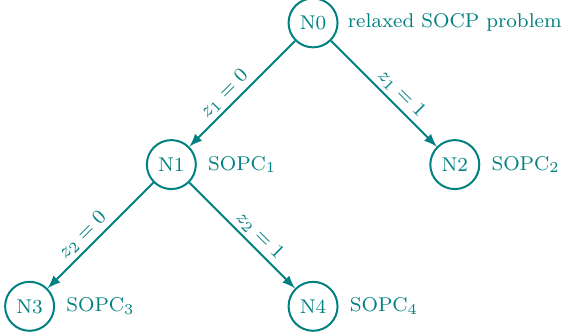
Figure 2. Schematic representation of the branch and bound method for mixed-integer second-order cone programming (MI-SOCP)